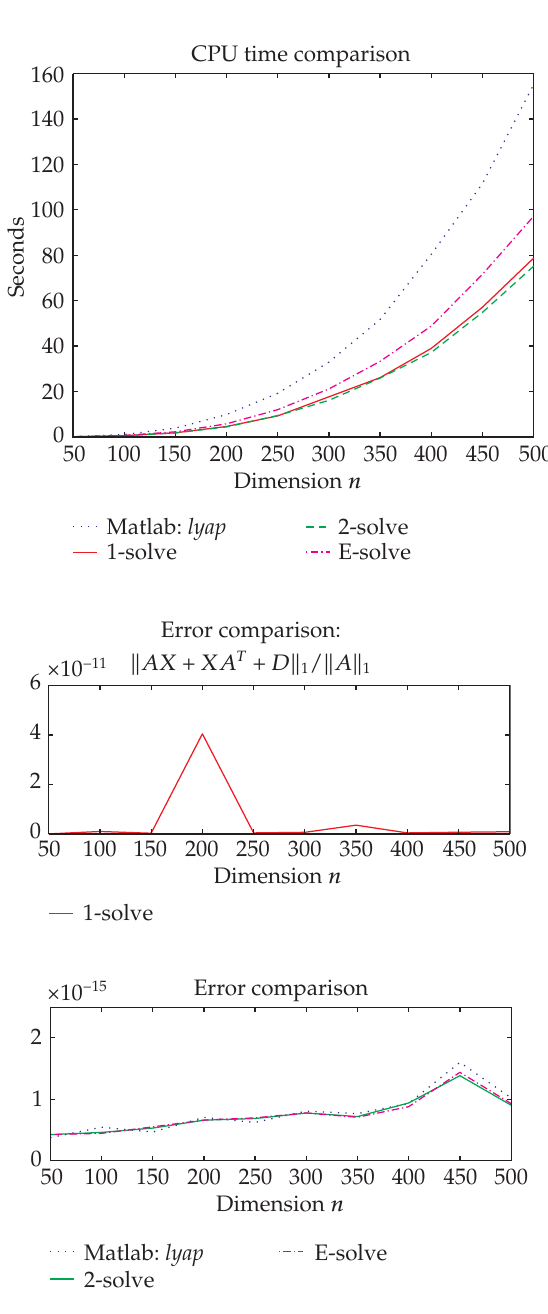
Figure 2.2 . Comparison of performance for Lyapunov equation ( 2.33 )